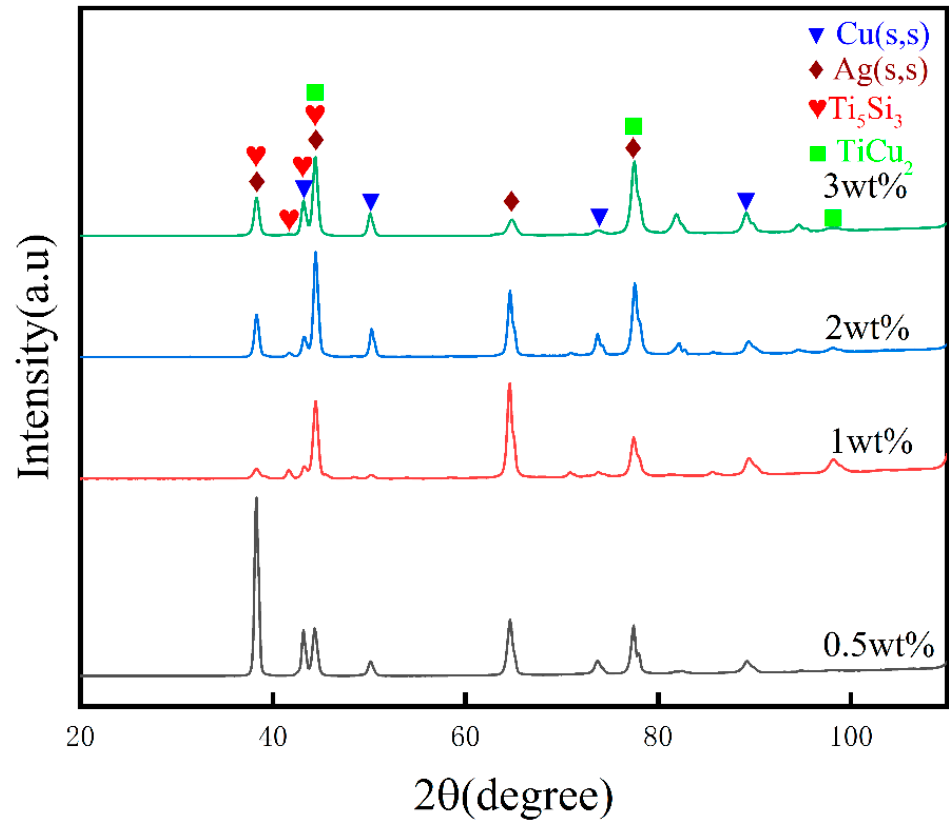
Figure 7. XRD patterns of micro-zones of brazed SiC joints with AgCuTi and different LiAlSiO 4 doping at 900 °C/10 min.